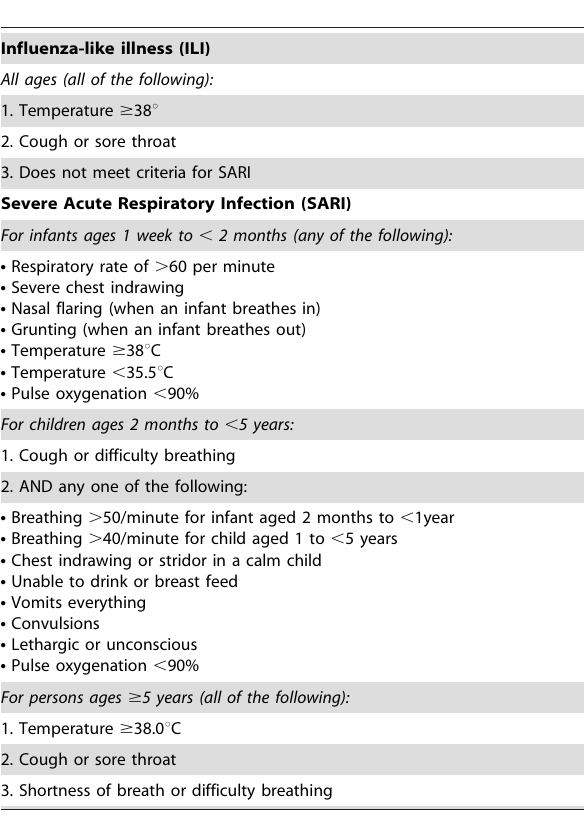
Table 1. Case definitions of influenza-like illness and